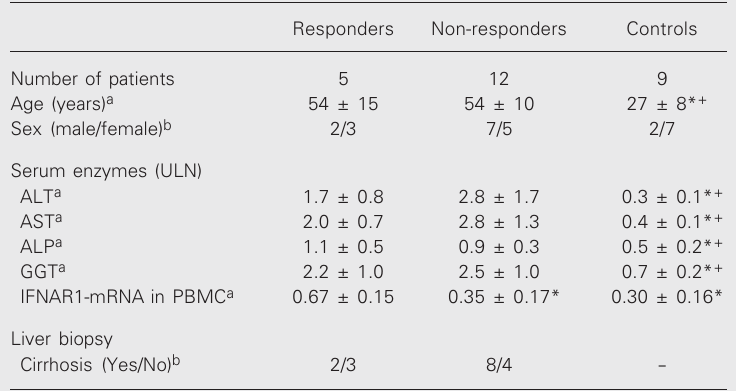
Data are reported as means ± SD for the number of individuals indicated in the first entry to the table. ALT = alanine aminotransferase; AST = aspartate